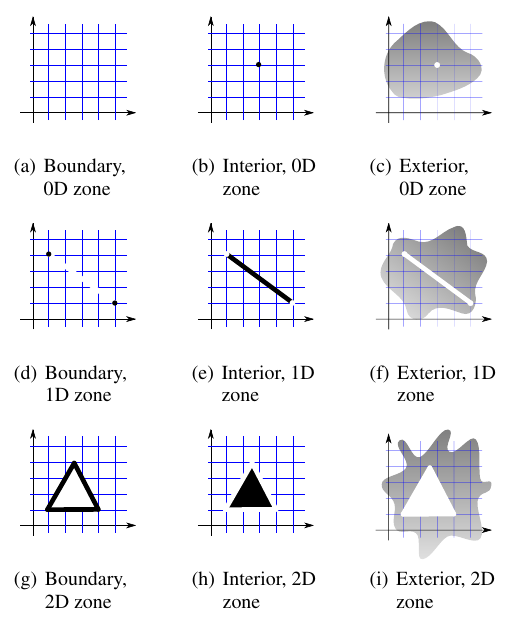
Figure 1: Boundary, interior, exterior for 0D, 1D and 2D zones (intent illustrated in black/dark grey). Note that a 0D zone does not have a boundary (by definition there will not be any primitives with dimension < 0 ).